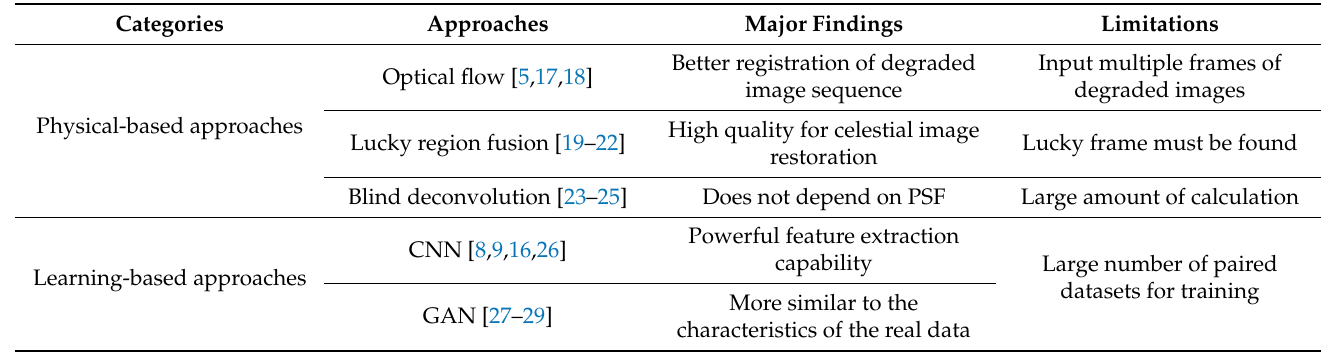
Table 1. The major findings and limitations of the existing restoration